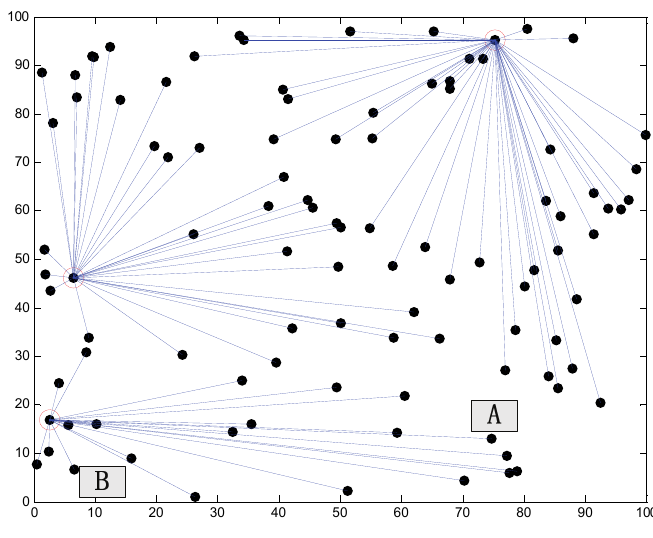
Figure 3. Diagrams for Reasons of Blind